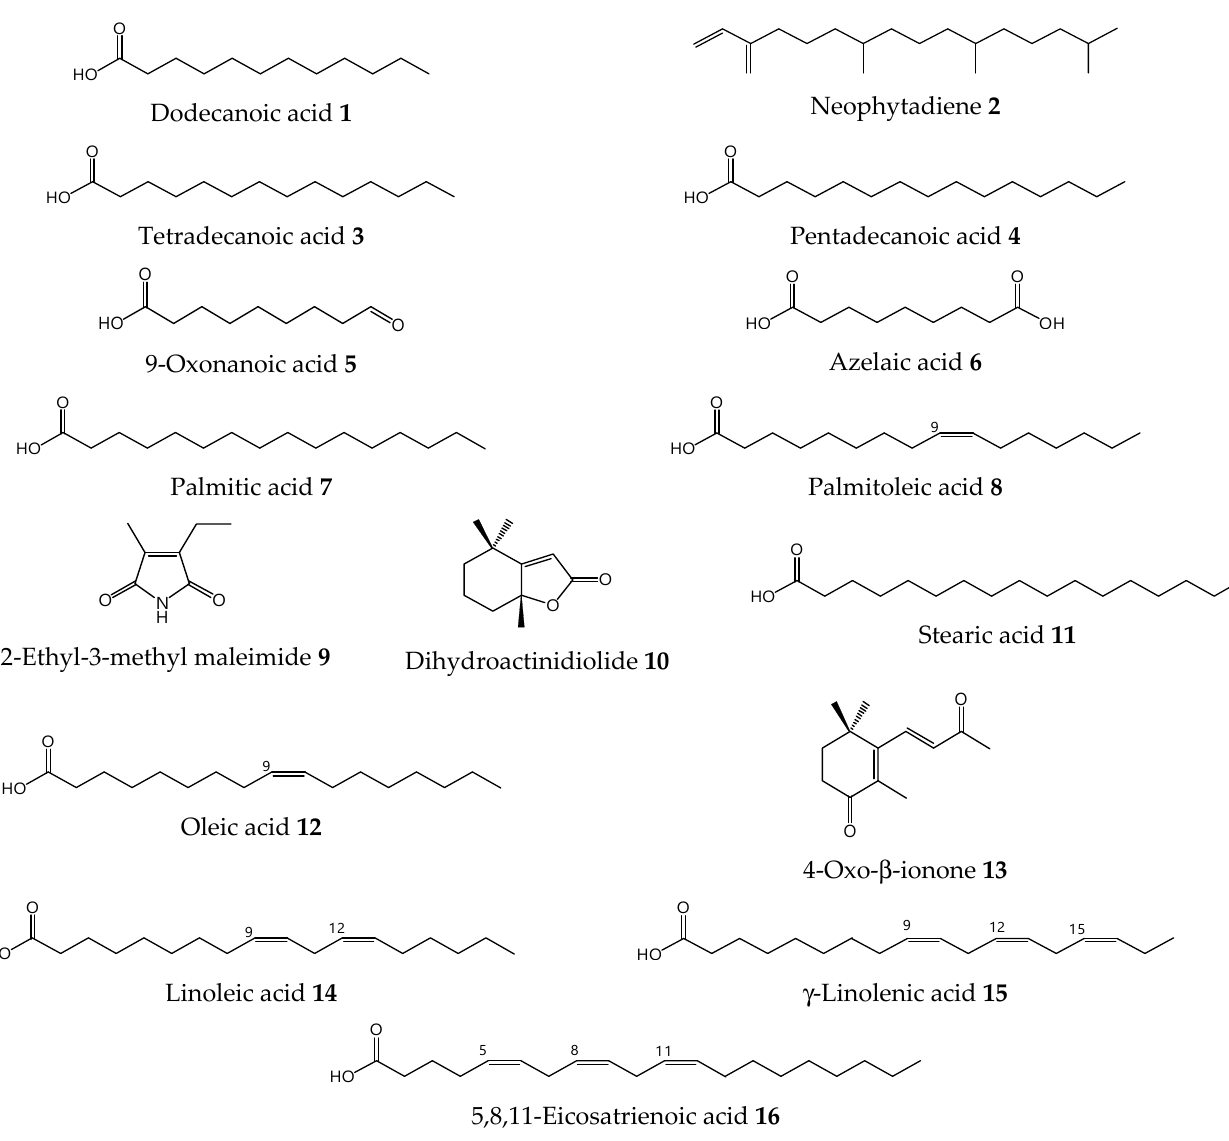
Figure 5. Compounds detected in allelopathic subfractions E6F3–E6F5 of S. platensis. Fraction E13 (650.0 mg) was re-eluted by CC on silica gel by using n- hexane/EtOAc (95:5) and EtOAc to increase the proportions of the polar solvent. The six resulting sub- fractions were screened for allelopathic activity at concentrations of 125–1000 ppm. E13F2 (56.4 mg, eluted with n -hexane/EtOAc 96:4), E13F3 (112.5 mg, eluted with n -hexane/EtOAc 96:4–95:5), and E13F4 (88.3 mg, eluted with n -hexane/EtOAc 95:5) exhibited high inhibitory activity. Fifty milligrams of subfraction E13F2, E13F3, and E13F4 were combined and treated by FCC by using silica gel 60. The mixture was eluted by using an n -hexane/EtOAc gradient to obtain four known compounds shown in Figure 6, 3-hydroxy- β -ionone 17 (27.0 mg), 3-hydroxy-5 α ,6 α -epoxy- β -ionone 18 (7.5 mg), 3-hydroxy-5 β ,6 β -epoxy- β -ionone 19 (6.9 mg), and loliolide 20 (35.0 mg). By comparison of their spectral analyses with those reported in the literature, these compounds were identified as dihydroactinidiolide 10 , 4-Oxo- β -ionone 13 , 3-Hydroxy- β -ionone 17 , 3-Hydroxy-5 α , 6 α -epoxy- β -ionone 18 , 3-Hydroxy-5 β , 6 β -epoxy- β -ionone 19 , and Loliolide 20 . The isolated compounds were identified by 1 H NMR and 13 C NMR as shown below.